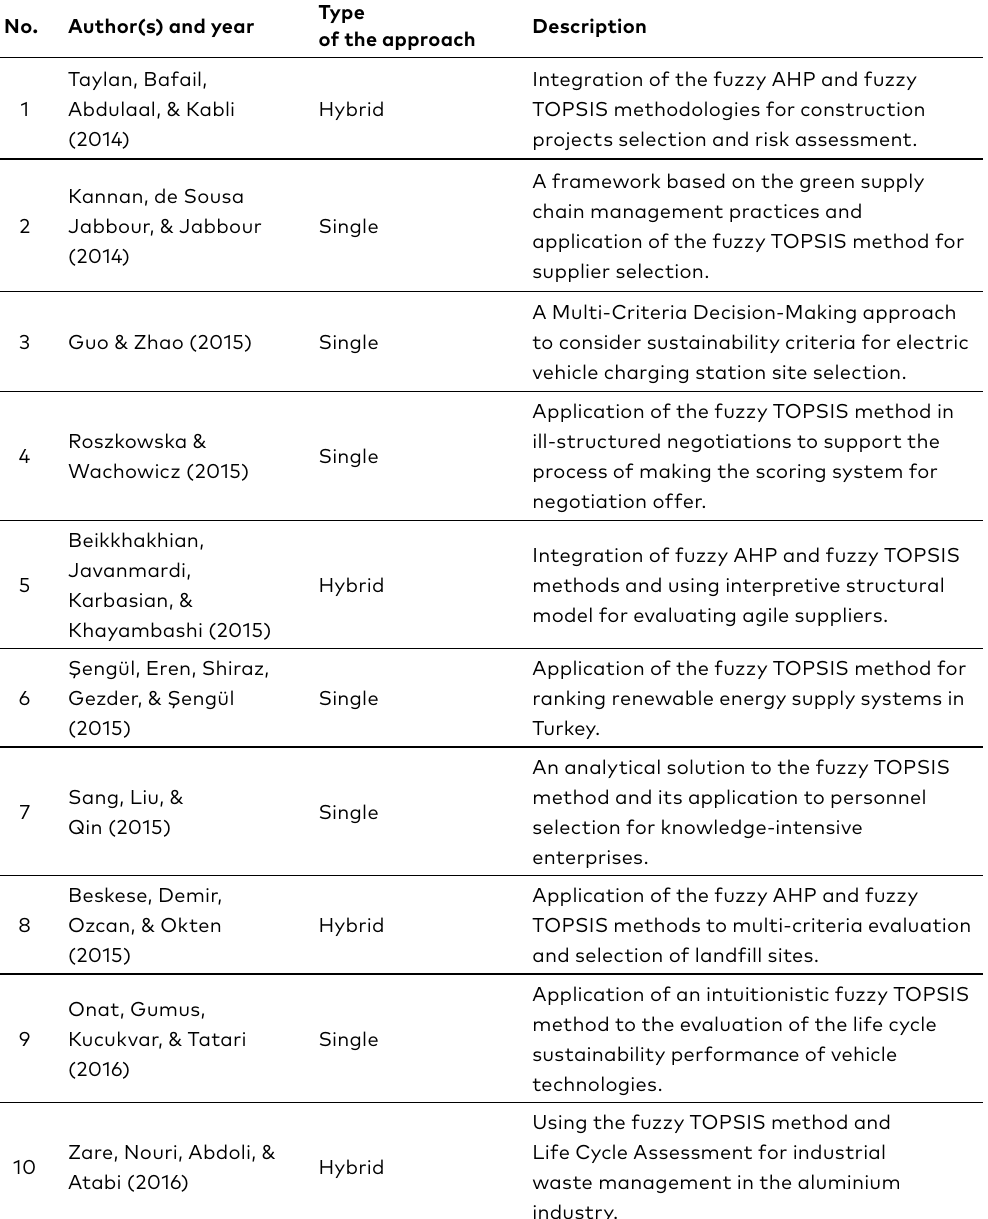
Table 2. Applications of fuzzy Technique for Order of Preference by Similarity to Ideal Solution approach in different